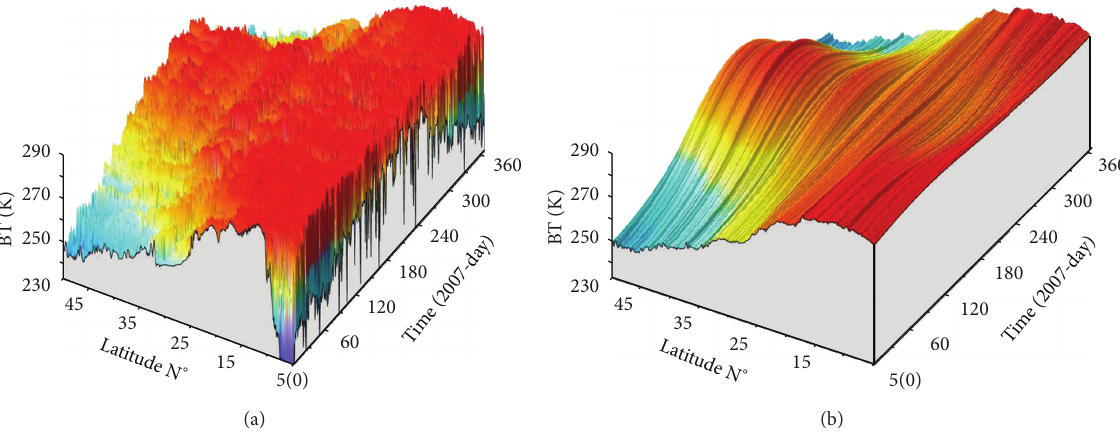
Figure 1: Wavelet transform (WT) result. (a) Raw data; (b) wavelet transform data of seven order criterion function